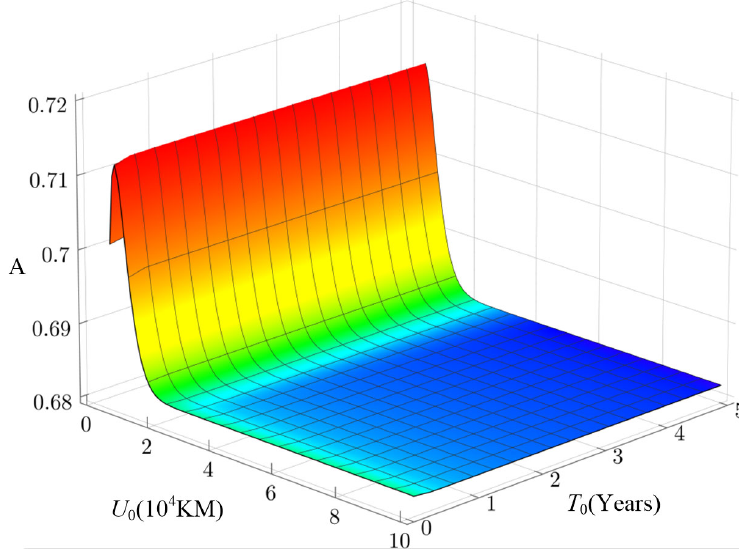
Figure 5. System availability change.